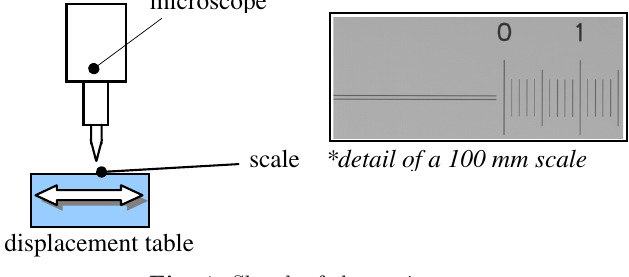
Fig. 1. Sketch of the equipment.